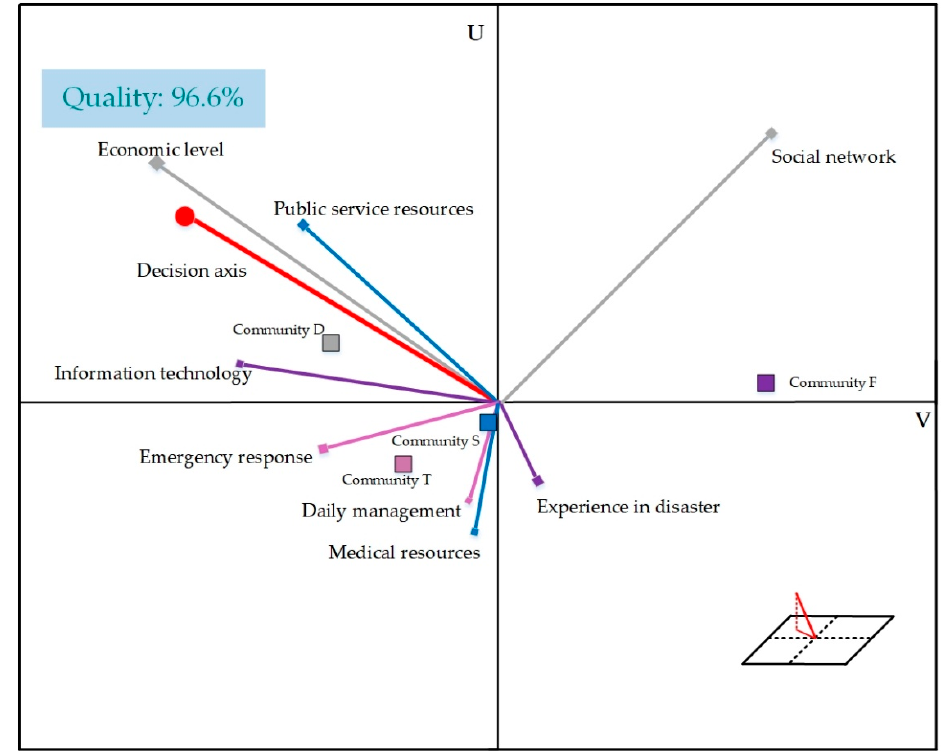
Figure 5. Performance of community epidemic resilience.